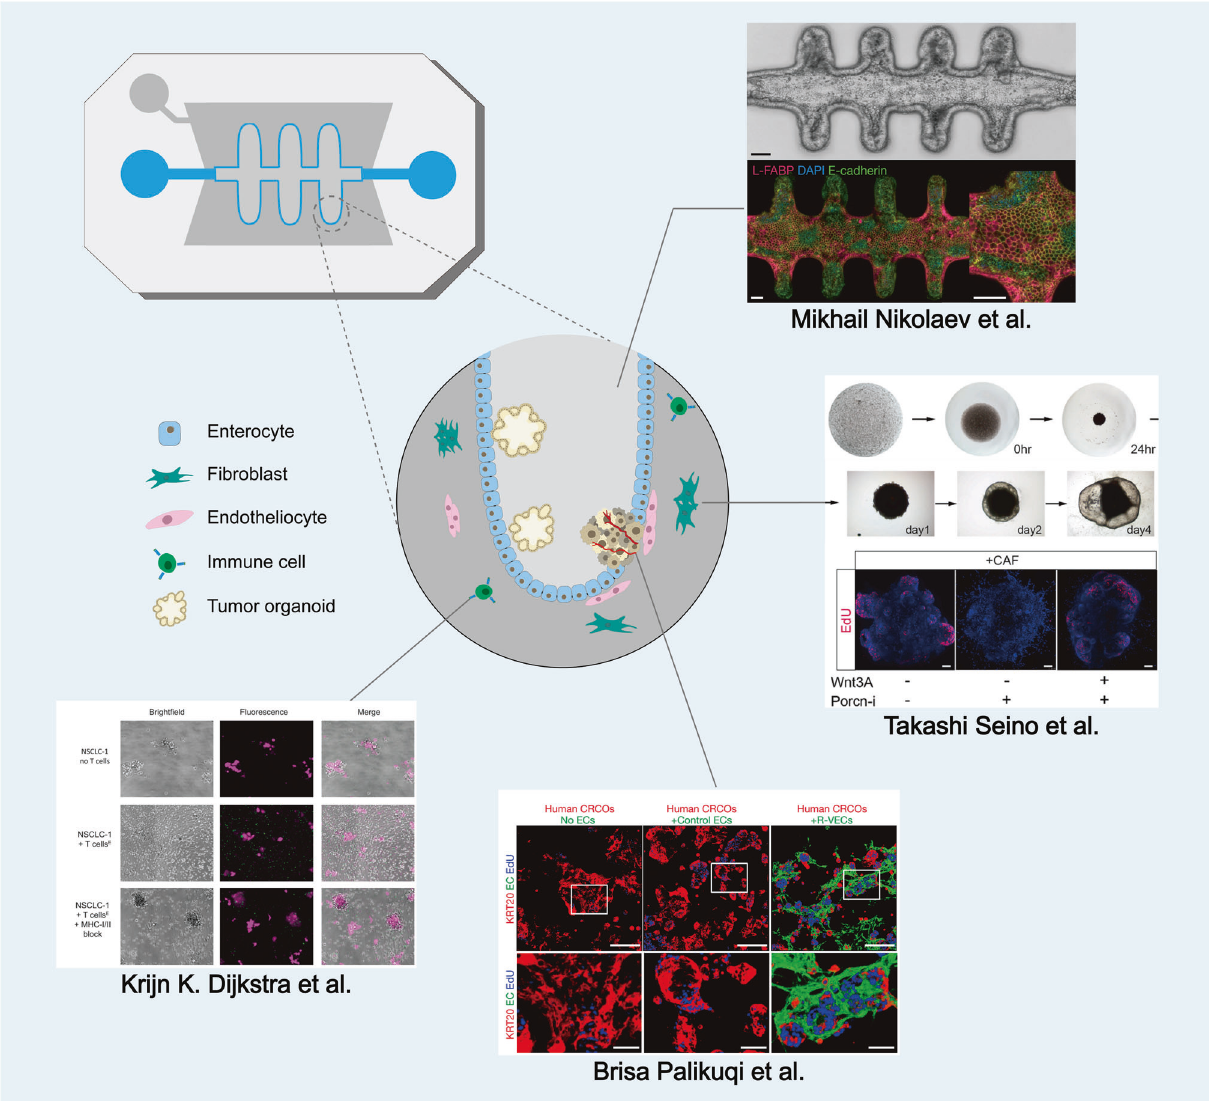
Fig. 3 Organoids meet organs-on-chips to perfect the quasi-physiological structure. The fi gure depicts a possible future, more potent in vitro technology by loading organoids and other stromal cells into micro fl uidic chips to complement the limitation of the two models. One channel was loaded with cancer organoids and enterocytes, while the other was coated with stromal cells. The middle fi gure is based on Ref. [126]. The top right is adapted from Ref. [126], Springer Nature Limited. The middle right is adapted from Ref. [116], Cell Limited. The lower one is adapted from Ref. [125], Springer Nature Limited. The lower left one is adapted from Ref. [100], Cell Limited. The surrounding experimental fi gures do not represent the actual situation of this